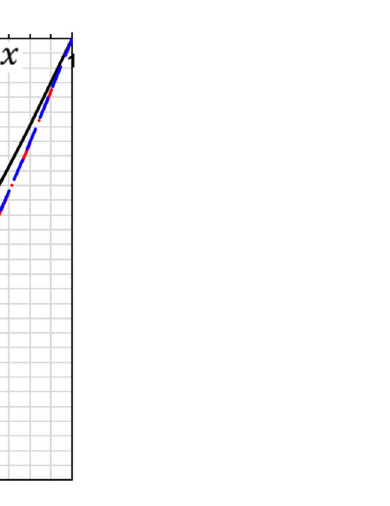
Figure 2. The transversal deflection w with the non-local parameter ξ